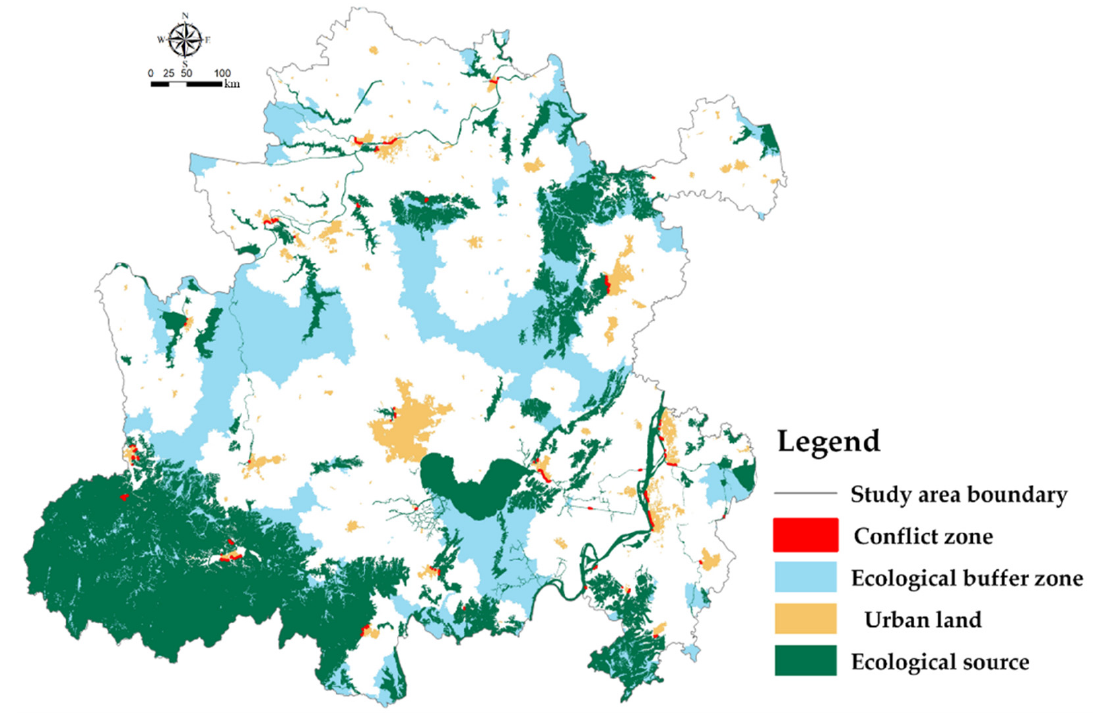
Figure 9. Ecological protection of the Hefei Metropolitan Area and identification of urban expansion land.